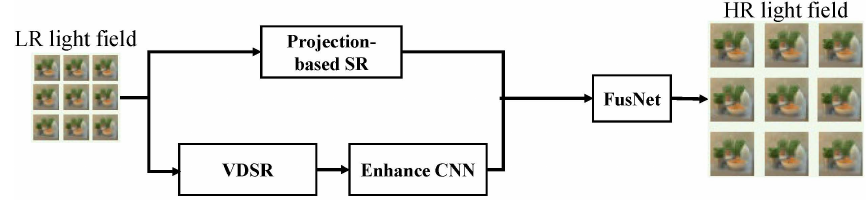
Figure 10. Network structure proposed by Cheng